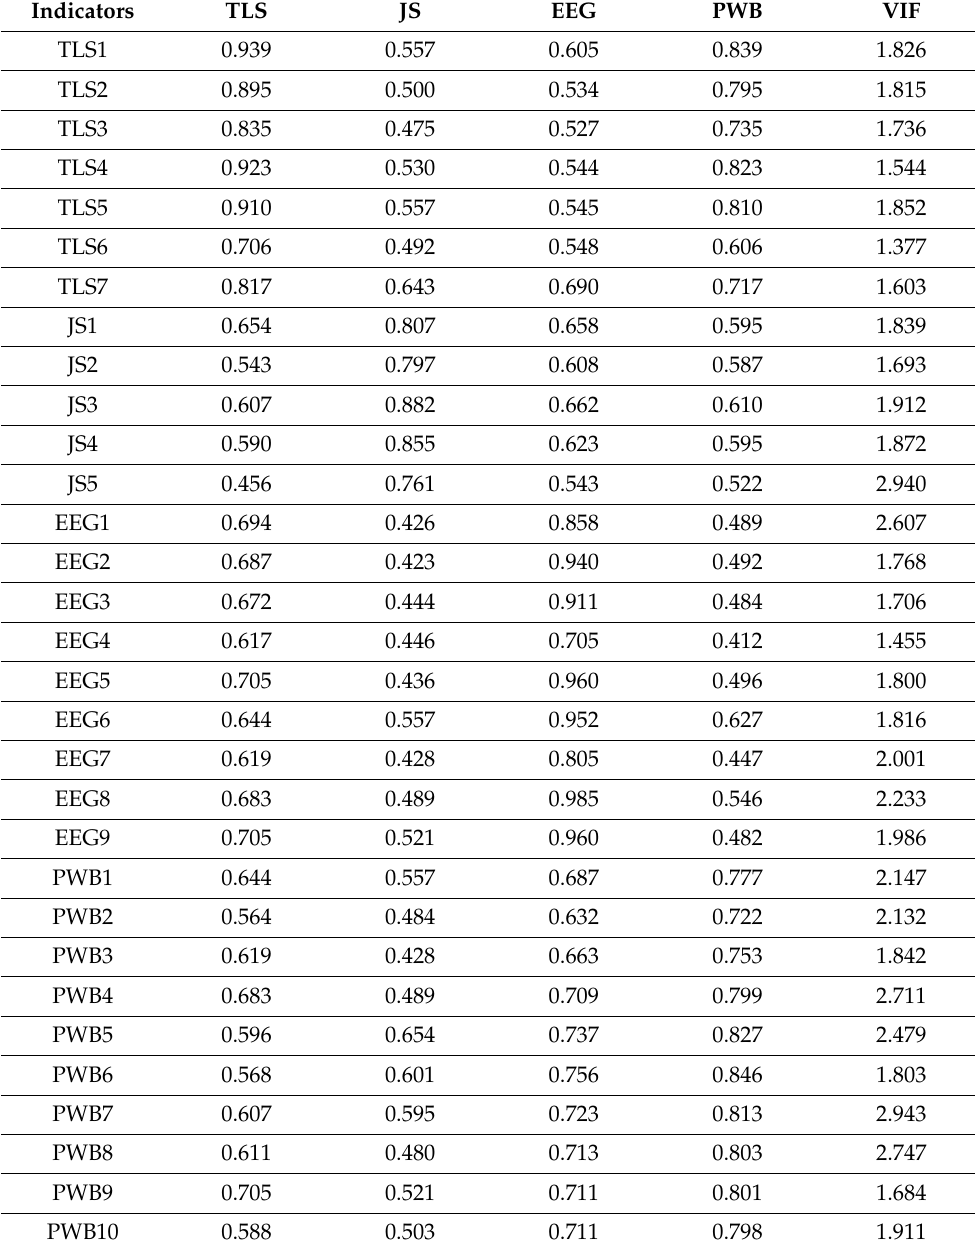
Table 4. Discriminant validity by indicator cross-loading and collinearity statistics